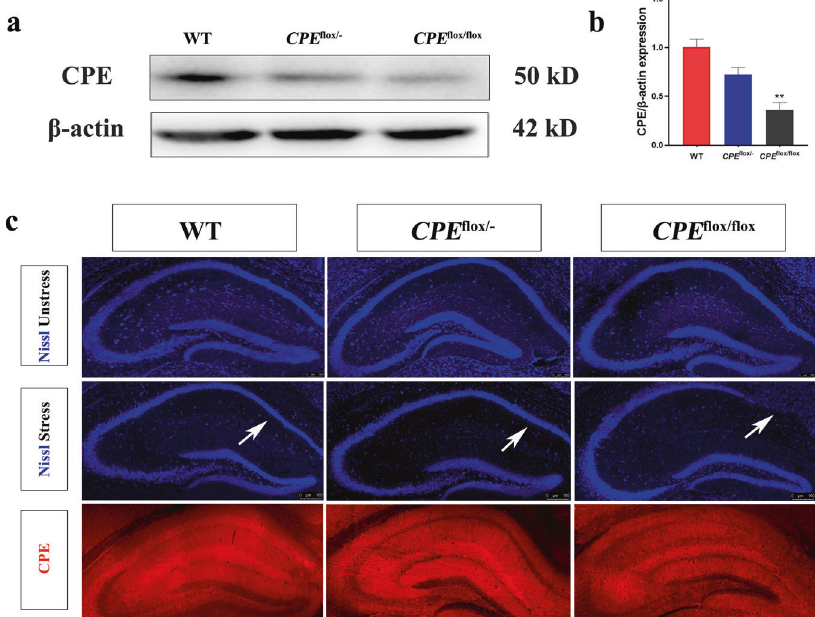
Fig. 3 CPE fl ox/ fl ox mice show hippocampal neurodegeneration after the stress paradigm. a , b Western blot analysis of CPE levels in the hippocampus. c Nissl (stress and unstress) and immuno fl uorescence staining of CPE in the hippocampus of WT, CPE fl ox/ − , and CPE fl ox/ fl ox mice. n = 6; * P < 0.05 and ** P < 0.01 compared with WT; values are mean ±